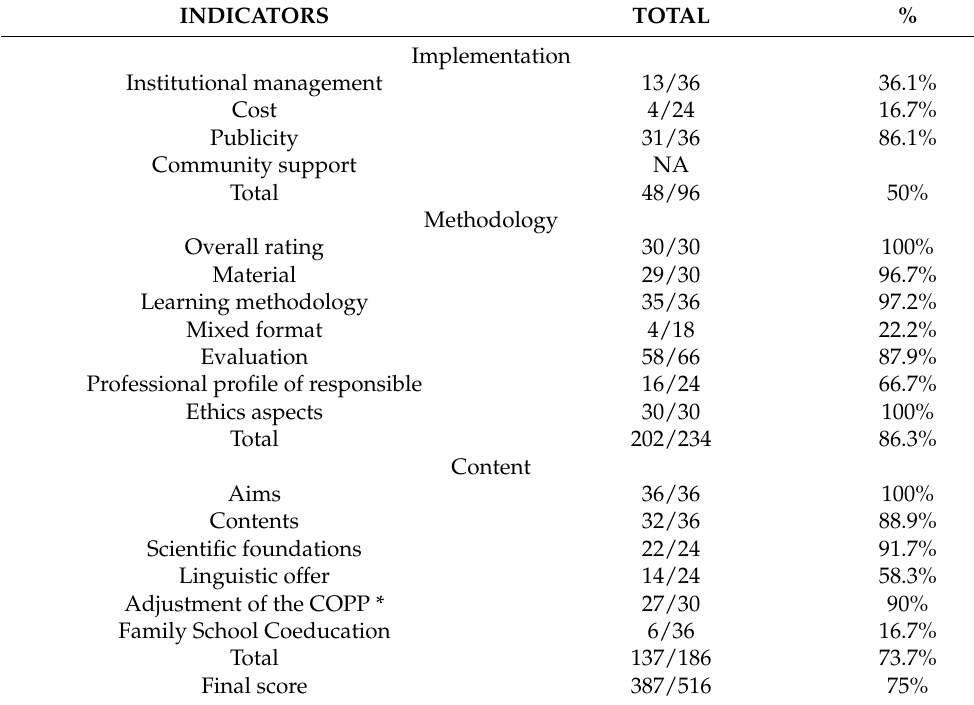
Table 4. Aspects that deserve improvement are those regarding the costs, the adaptation of the program to several languages, the use of a website and the lack of relationship with school context. Table 4. Quality of the